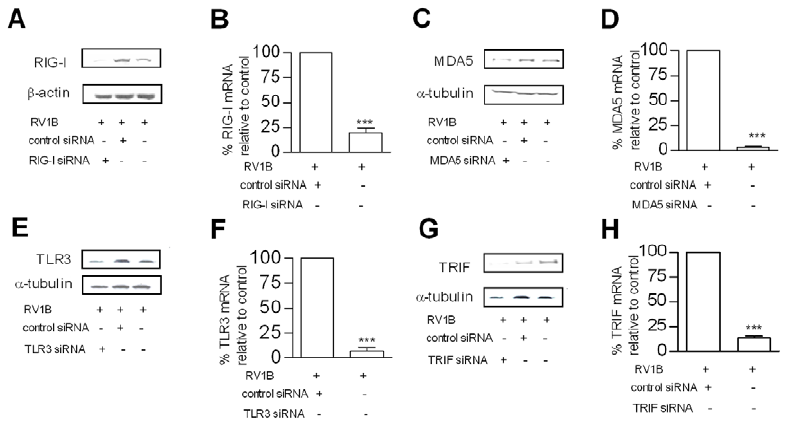
Figure 3. Effects of each siRNA on RIG-I, MDA5, TLR3 and TRIF mRNA and protein levels. HBECs were transfected with siRNA specific for RIG-I or control siRNA, infected with RV1B and RIG-I protein (A) and mRNA (B) measured. HBECs were transfected with MDA5 specific siRNA or control siRNA and infected with RV1B and MDA5 protein (C) and mRNA (D) measured. HBECs were transfected with siRNA specific for TLR3 or control siRNA and infected with RV1B and TLR3 protein (E) and mRNA (F) measured. HBECs were transfected with siRNA specific for TRIF or control siRNA and infected with RV1B and TRIF protein (G) and mRNA (H) measured. * p , 0.05, ** p , 0.01, *** p , 0.001 versus control siRNA or as indicated. mRNA data was generated from 6 independent experiments utilizing 3 independent HBEC donors, 2 experiments per donor.